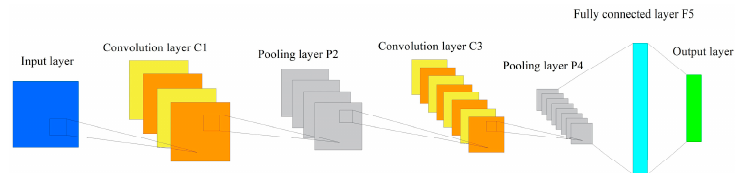
Figure 1. A typical architecture of CNN.